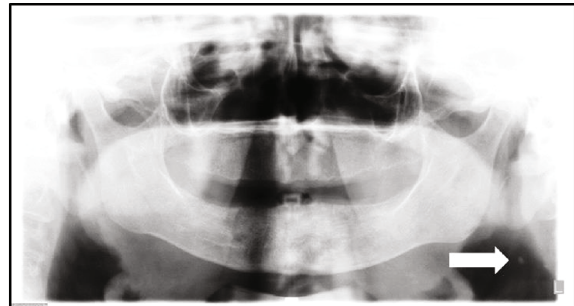
Figure 6: Panoramic radiograph showing the presence of radiopaque mass circumscribed on the left side of the cervical region